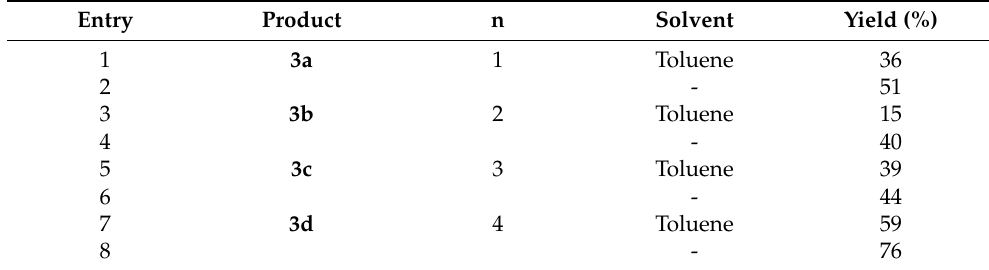
Table 2. 2,5-Dialkyl-1,3,4-oxadiazole derivatives ( 3a – d ) formed by cyclization of N , N (cid:48)